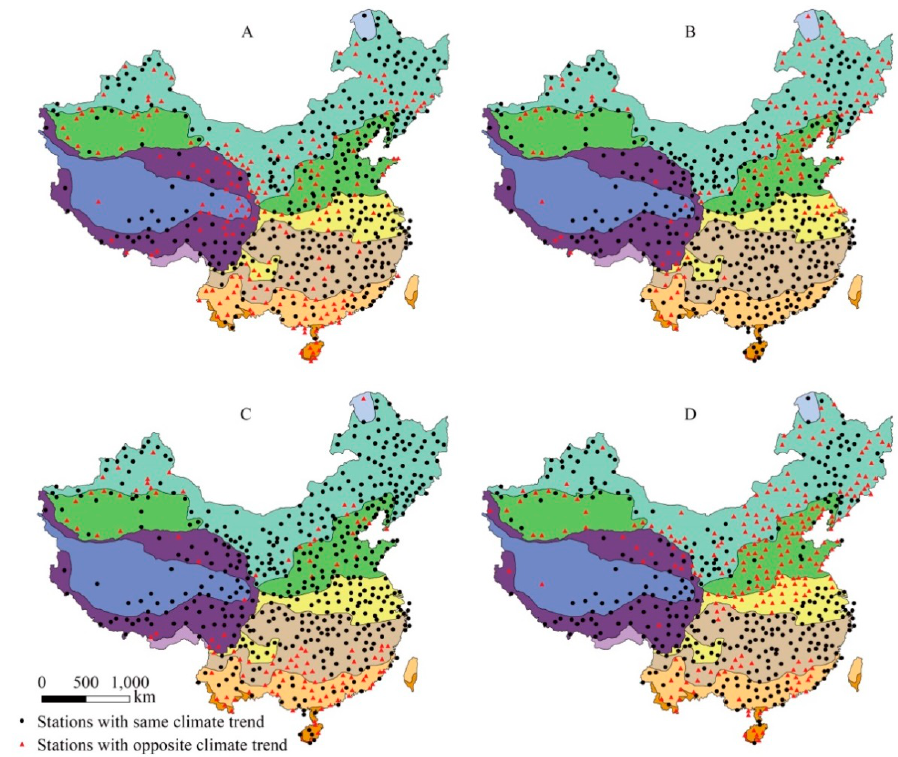
Figure 5. Climate trend of daily minimum temperature for January 1st ( A ), April 1st ( B ), July 1st ( C ) and October 1st ( D